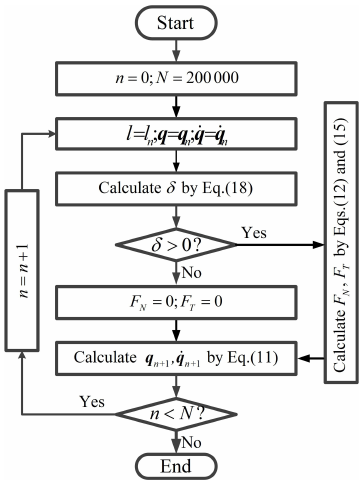
Figure 12. Flow chart of simulation